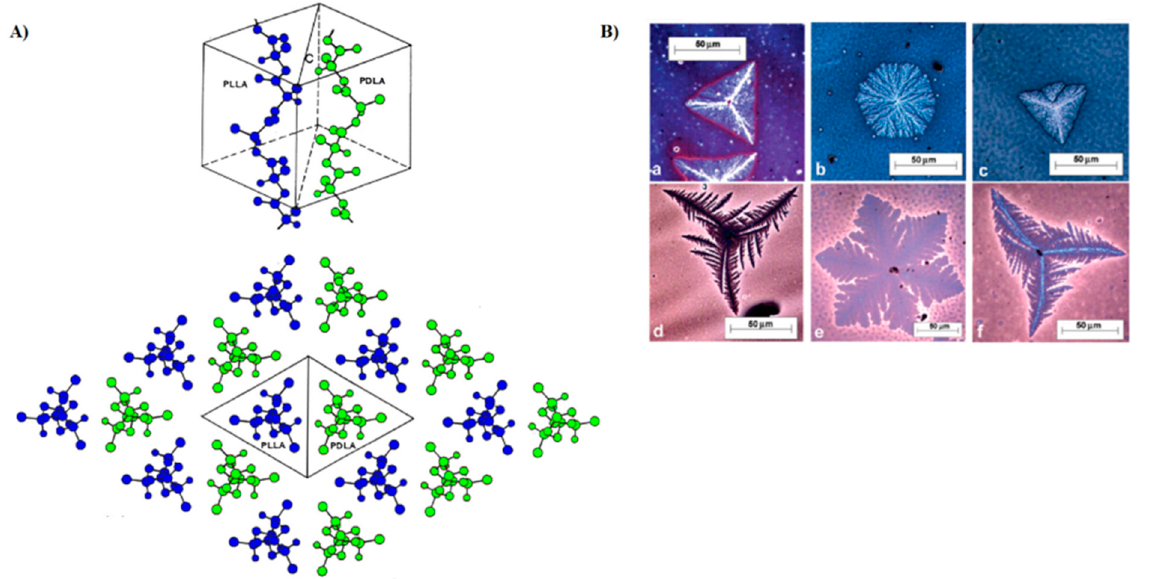
Figure 5. ( A ) SC crystalline lattice; adapted from [115] with permission from Elsevier. Copyright© 2016. ( B ) Optical microscopy micrographs of different PLLA/PDLA films with PLLA content of 75% ( a , d ), 50% ( b , e ), and 25% ( c , f ), crystallized at 200 °C; reproduced from [116] with permission from American Chemical Society. Copyright © 2010.